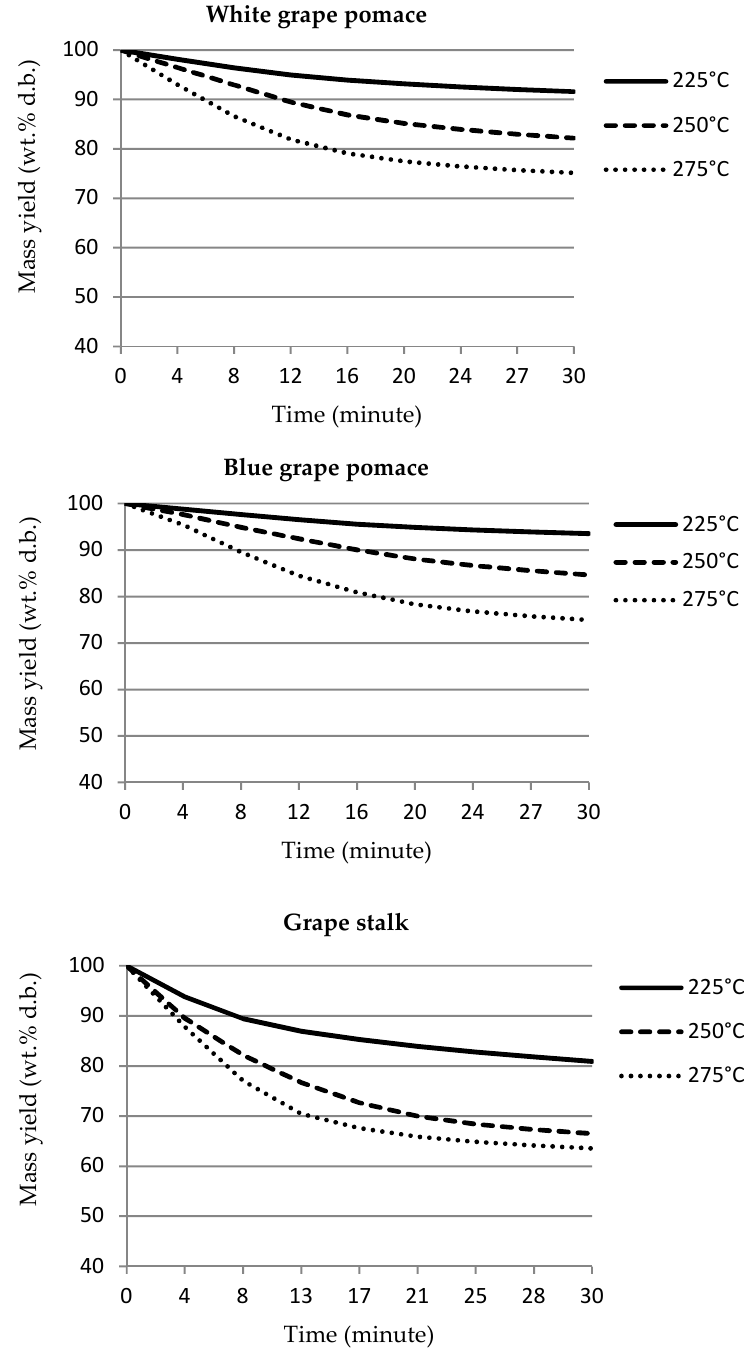
Figure 1. Mass loss curves of samples.